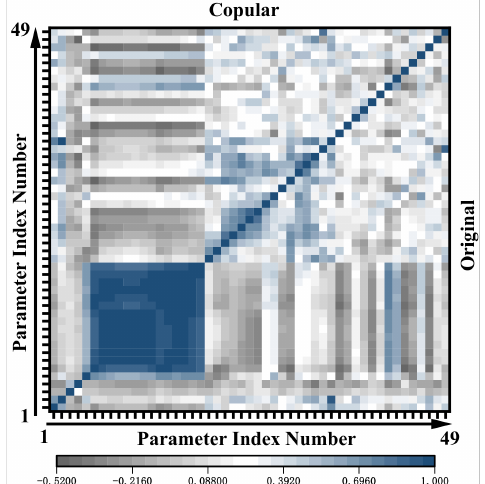
Figure 9. Correlation analysis on the parameter distribution of the newly generated data and the original